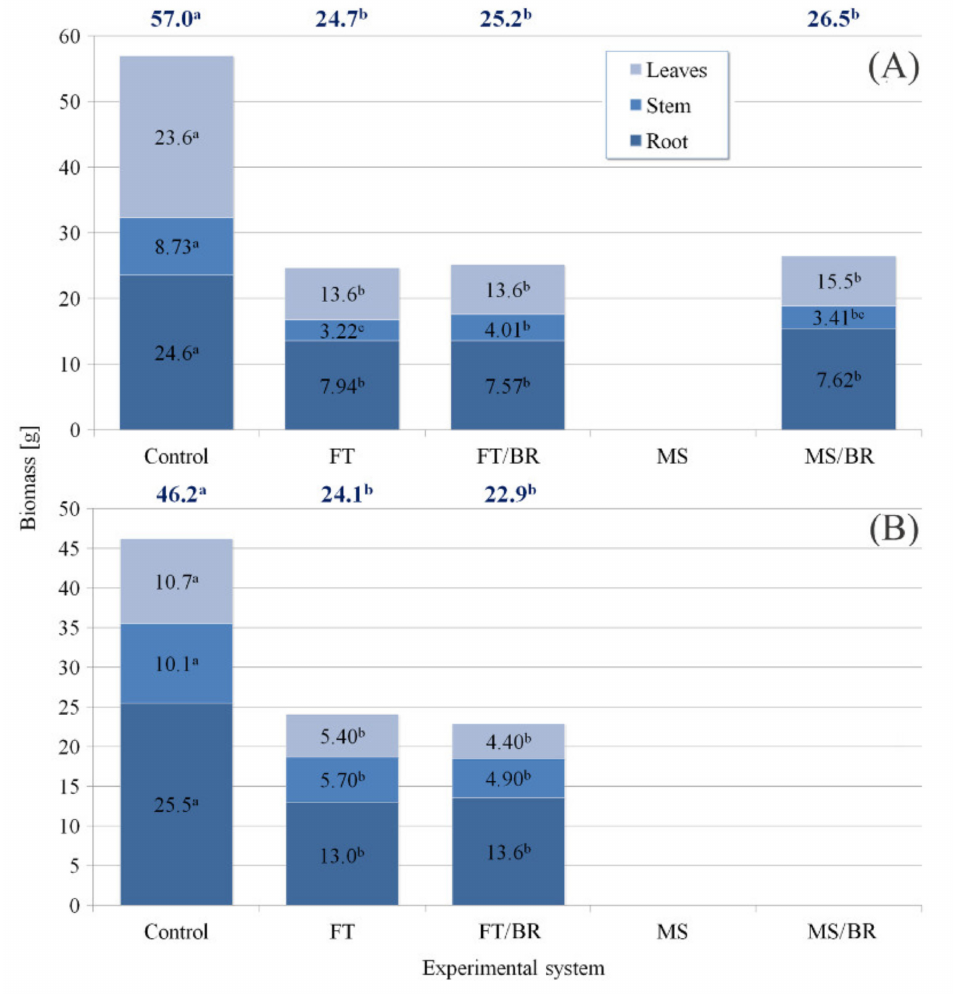
Figure 1. Characteristics of fresh biomass (g FW) of Paulownia growing under particular experimental systems in the first ( A ) and the second ( B ) year of investigation (identical lettering denote no significant ( p > 0.05) differences according to a post-hoc Tukey’s HDS test). In the first year, plant height reached 34.4 cm for the control and 25.9, 25.4 and 23.6